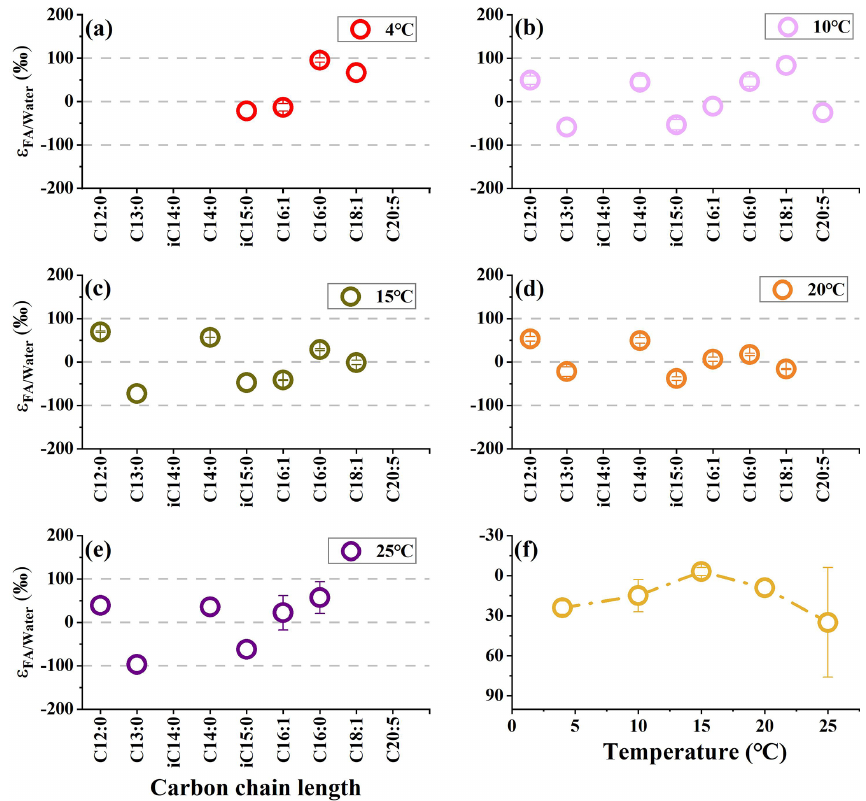
Figure 2. The hydrogen isotope composition of fatty acids in S. piezotolerans WP3 growing at different temperatures. Panel (f) shows the abundance-weighted mean ε FA / water values at different temperatures. The error bars represent the 1 σ standard deviations of duplicate cultures. None of the cultures have been shaken.